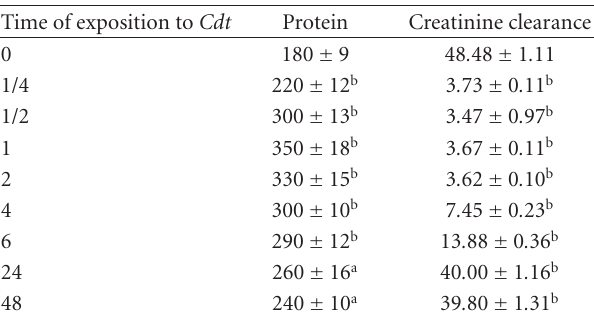
Groups of BALB/c female mice were injected i.p. with 1 LD 50 of Cdt for di ff erent times as described in Section 2. The presence of protein in